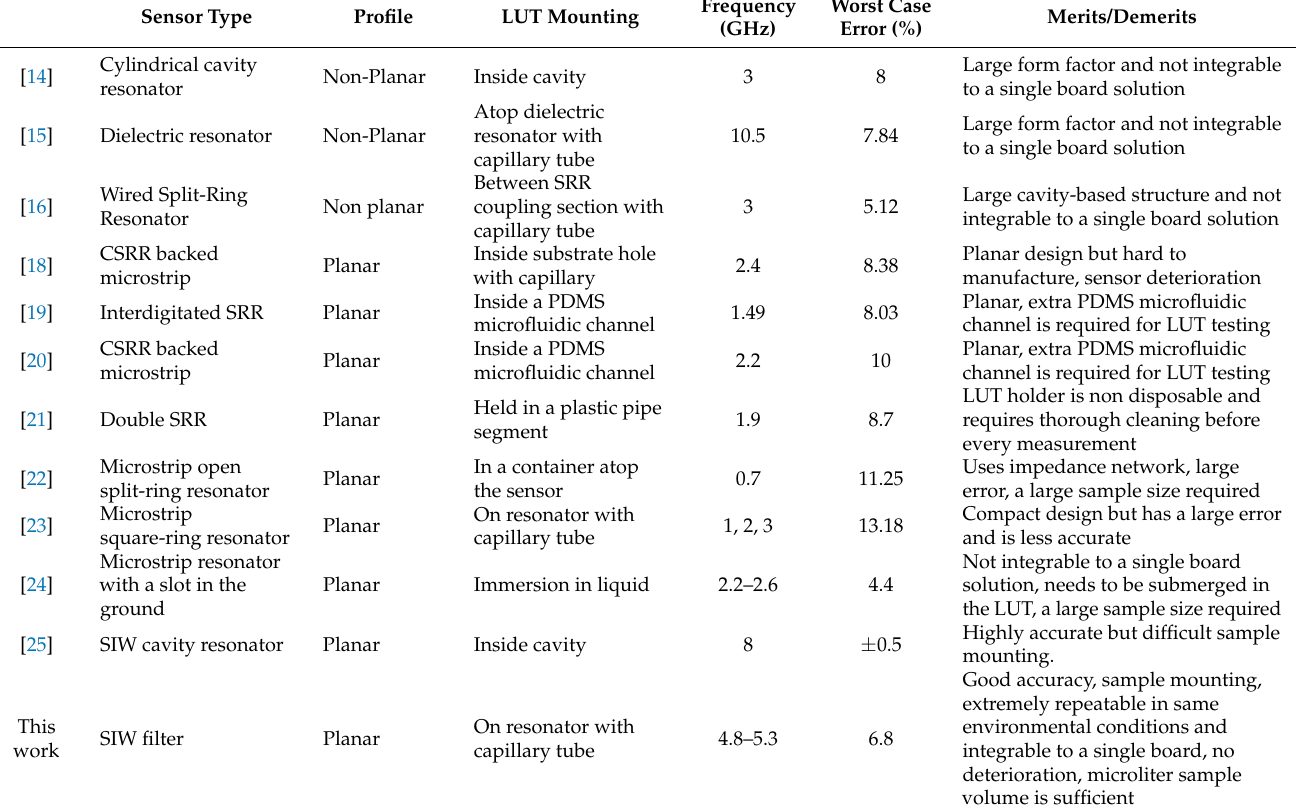
Table 2. Comparison of this work with other techniques reported in the